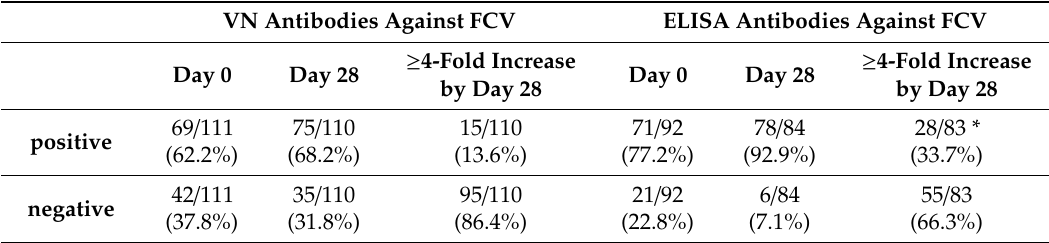
Table 3. Comparison of the results of enzyme-linked immunosorbent assay (ELISA) and virus neutralization (VN)